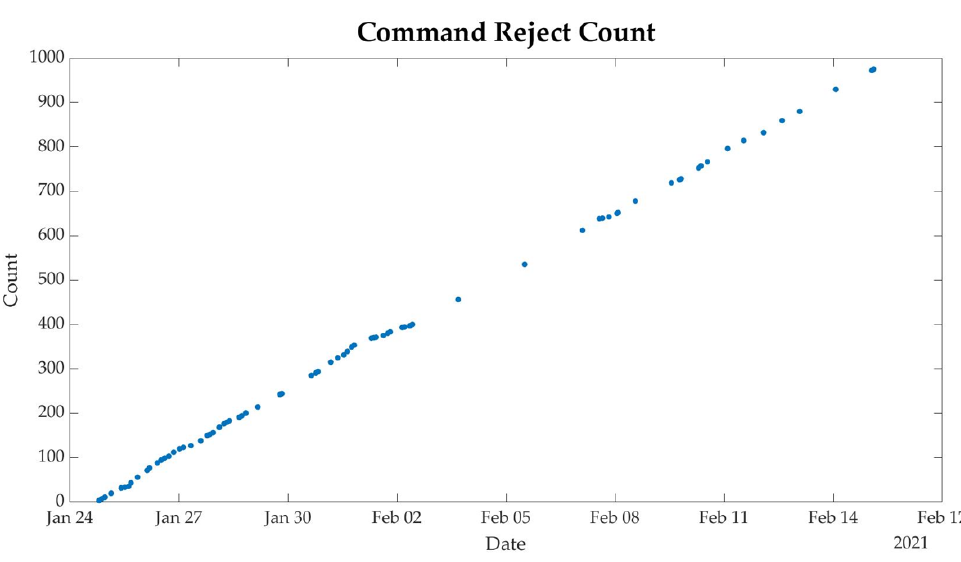
Figure 20. Command reject count in IDEASSat flight data.